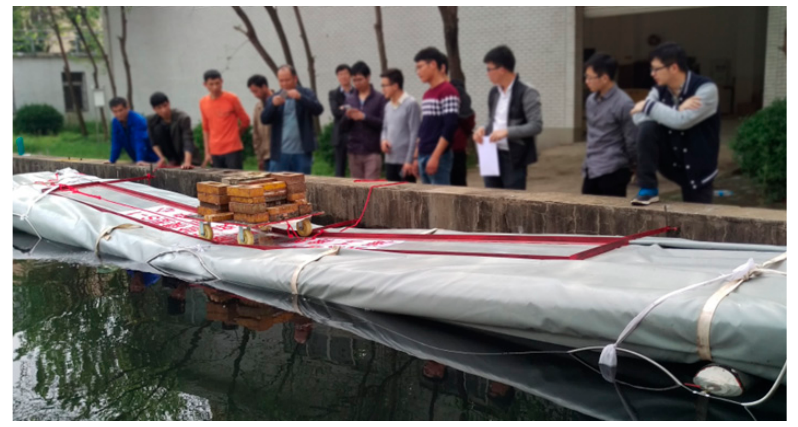
Figure 13. Experimental environment. Figure 13. Composite material and bearing unit model test. ( a ) Tensile test before breaking. ( b ) Tensile test after fracture.